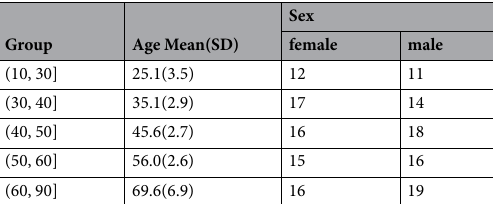
Table 1. Demographics of the groups in this study.